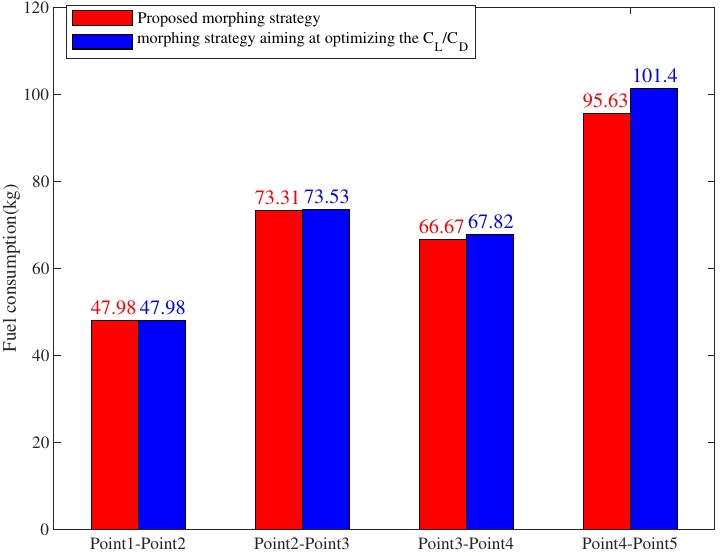
Figure 20. Fuel consumption for each cruise phase of the comparative simulation in Section 5.2.